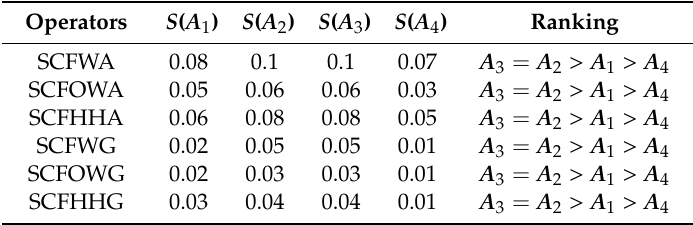
Table 7. Comparison and ranking of the